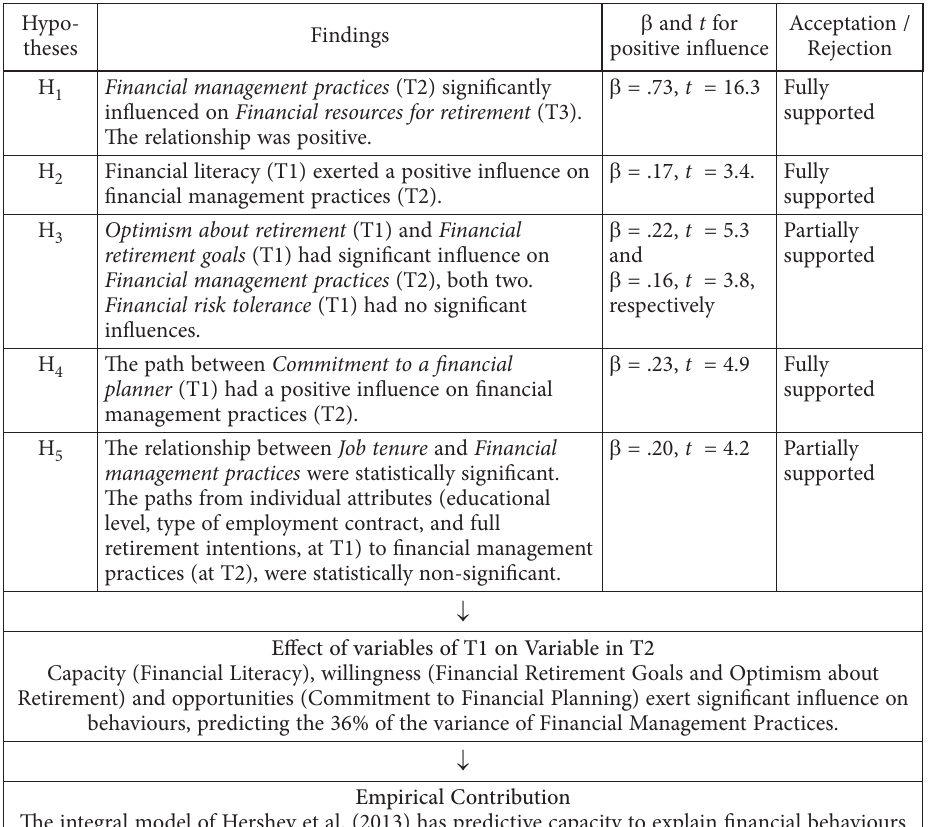
β and t for Acceptation / positive influence Rejection β = .73, t = 16.3 Fully